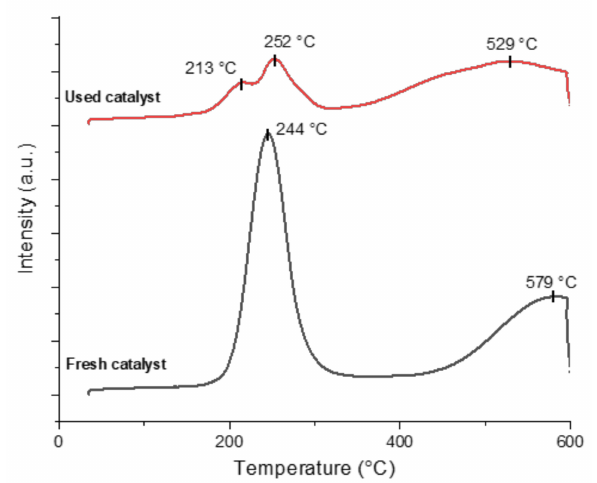
Figure 6. H 2 -TPR of the catalyst before and after reaction at 8 bar, 350 − 500 ◦ C.